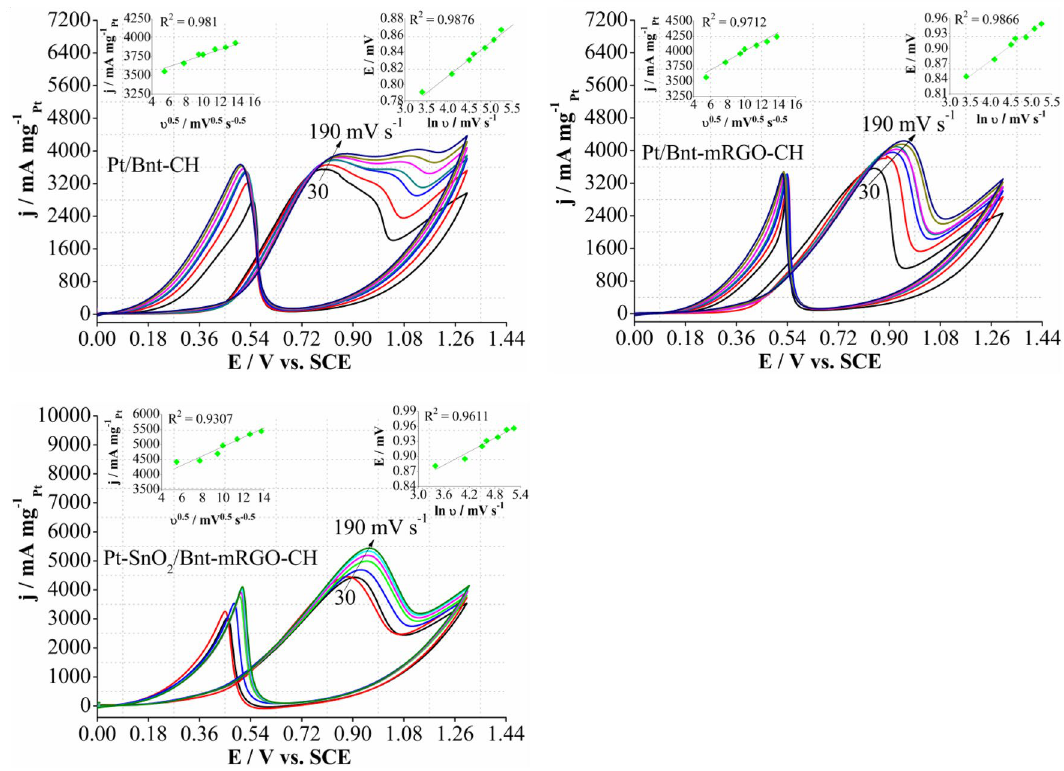
Figure 7. CV curves of the prepared catalysts in 0.5 M H 2 SO 4 and 0.72 M methanol at different scan rates of 30, 60, 90, 100, 130, 160, and 190 mV s −1